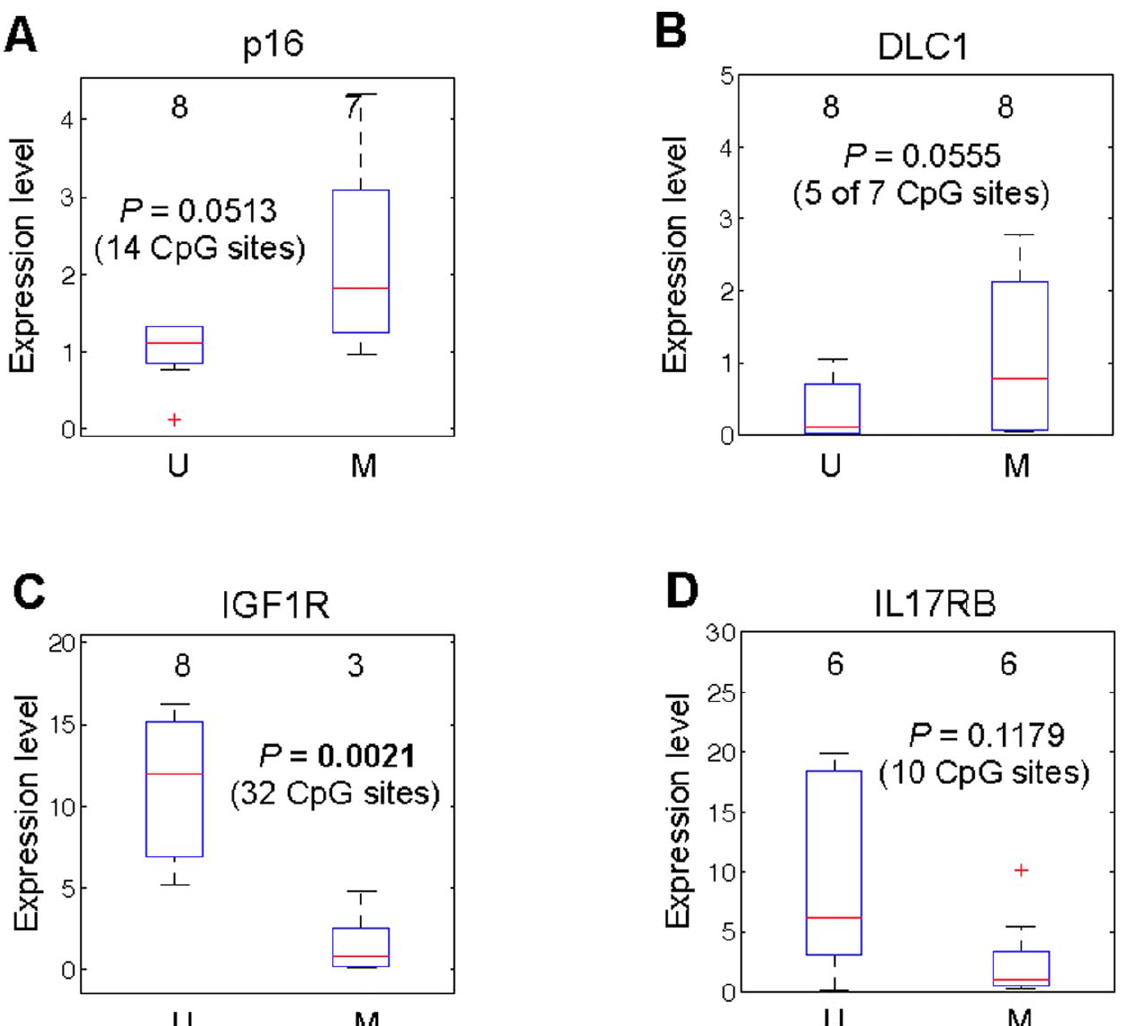
Figure 7. Validation of methylation-expression relationships using a discretization approach for p16, DLC1, IGF1R and IL17RB by pyrosequencing and qRT-PCR in an independent sample set. Bisulfite pyrosequencing data for 43 independent samples was used to discretize samples into methylated (M) or unmethylated (U) groups based on the percent methylation values obtained for p16 (A), DLC1 (B), IGF1R (C) and IL17RB (D). The average of all CpG loci interrogated by pryosequencing for each gene was used in the analysis. Differential gene expression analysis was conducted by qRT-PCR to compare the expression of each gene between U and M groups. Positive methylation-expression correlations were confirmed for p16 and DLC1. A negative correlation was validated for IGF1R and IL17RB. The number of patients in U and M groups is given above each box plot. Y-axis represents expression levels by plotting relative fold-change (2 2 DD CT ).